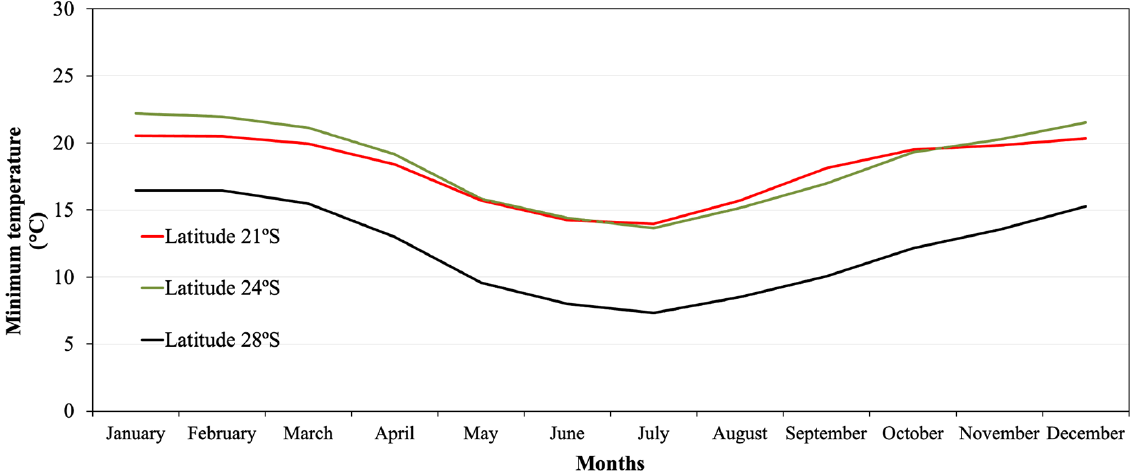
Figure 5. Minimum temperature (°C) throughout the year in three locations in Brazil: Lages, Santa Catarina state (latitude 28° S), Palotina, Parana state (24° S), and Ribeirao Preto, Sao Paulo state (21° S). A 25 km buffer was generated around each region to obtain monthly data from 1982 to 2021. The distribution of rainfall throughout the year also influences hop cultivation. The water requirement may vary according to the growing region, as the demand for hop evapotranspiration depends on temperature, wind, air humidity, and soil type [44].